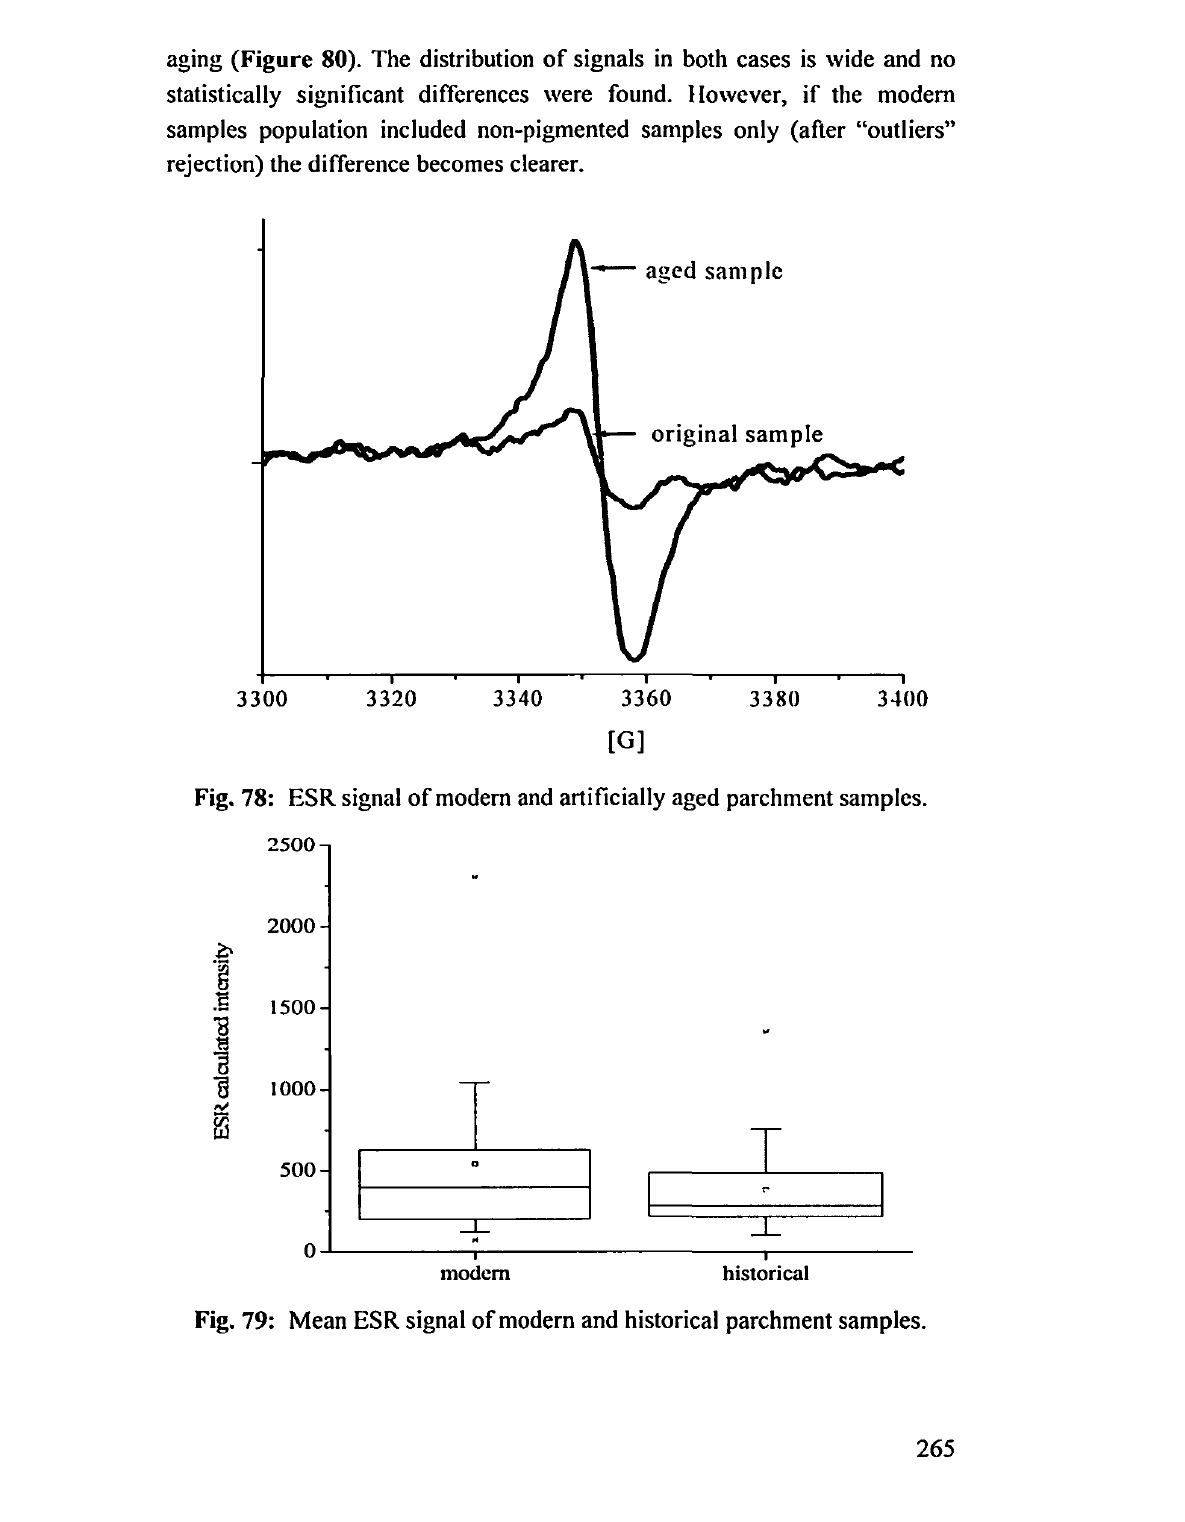
Fig. 79: Mean ESR signal of modern and historical parchment